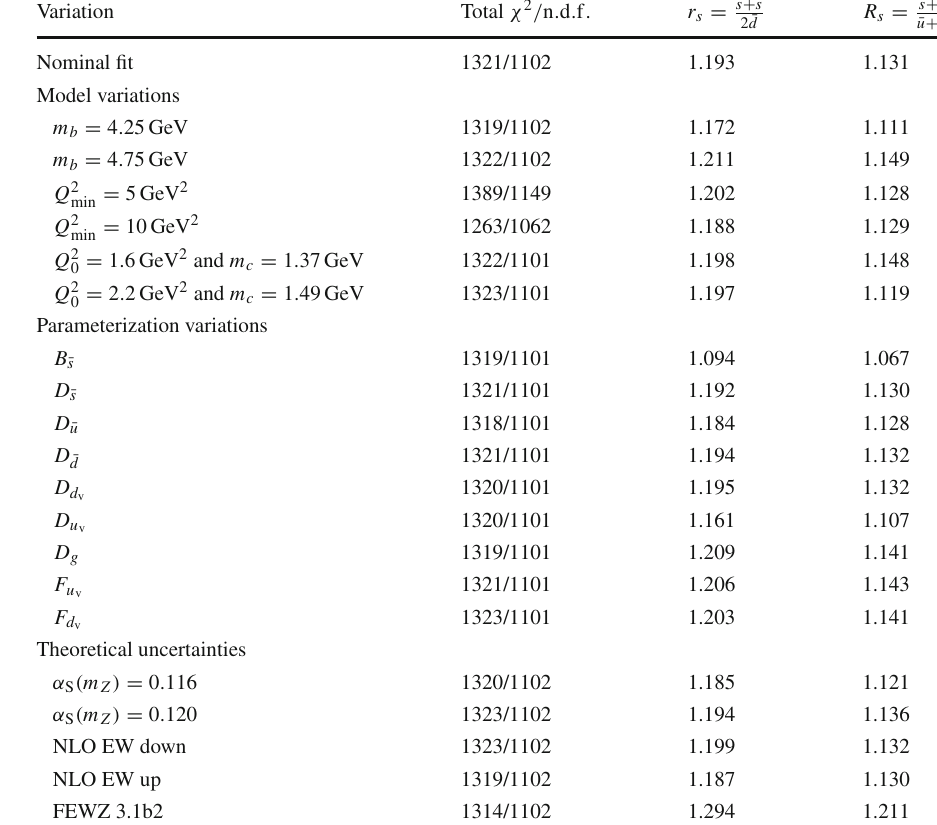
Table 19 Overview of the Variation Total χ 2 / n . d . f impact of variations in the QCD fit regarding the model, parameterization, and further theoretical choices as compared to the nominal fit. For each variation the total fit χ 2 / n . d . f . is given as well as the values of the two quantities r s and R s which describe the strange-to-light-sea-quark fraction at Q 2 and x = 0 . 023. In 0